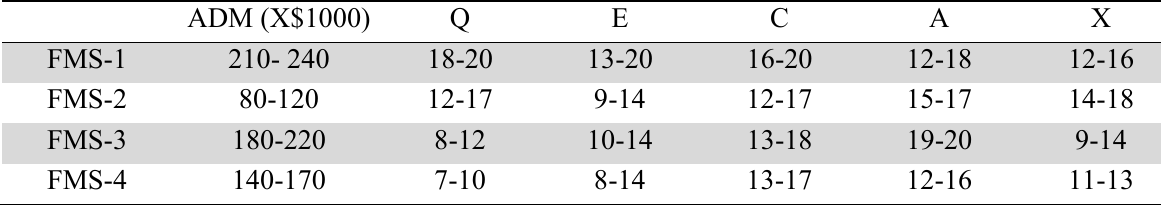
Interval data decision matrix for the selection of FMS